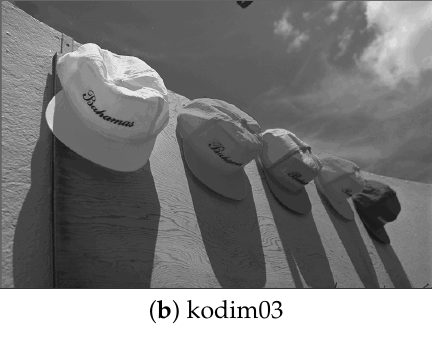
Figure 7. Test images.